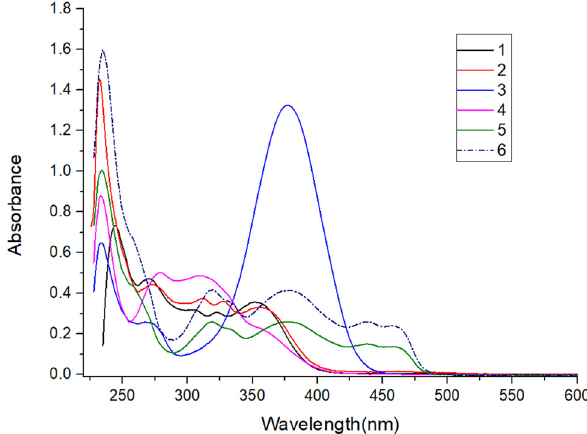
Figure 7: The UV - Vis spectra of complexes 1 – 6 in CH 2 Cl 2 ( 3.0 × 10 − 5 M )